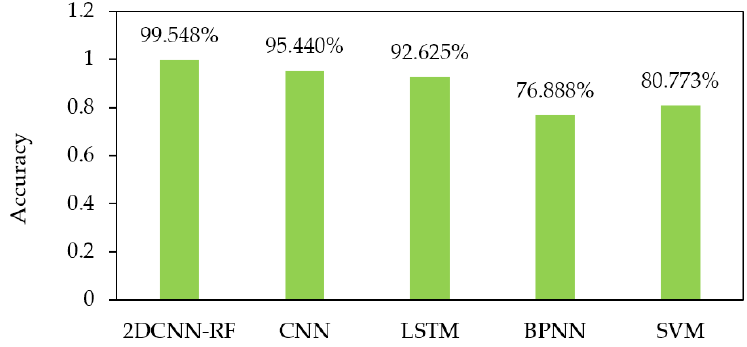
Figure 10. The average accuracy of fault diagnosis for different models.